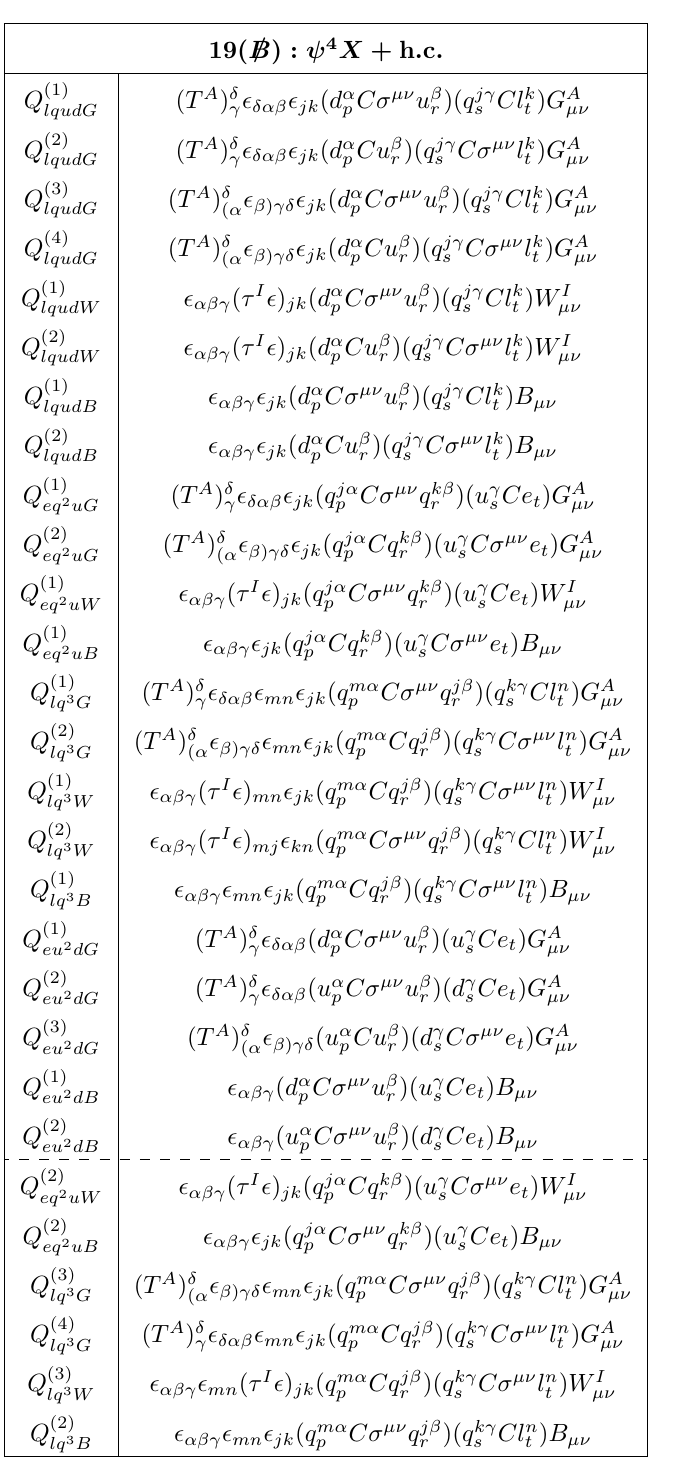
Table 15 . The baryon number violating dimension-eight operators of class-19. All of the operators have Hermitian conjugates. The subscripts p; r; s; t are weak-eigenstate indices. Operators below the dashed line vanish when there is only one generation of fermions.